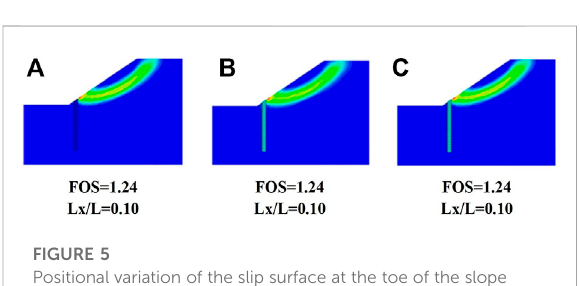
Figure 3 indicates a three-dimensional fi nite difference